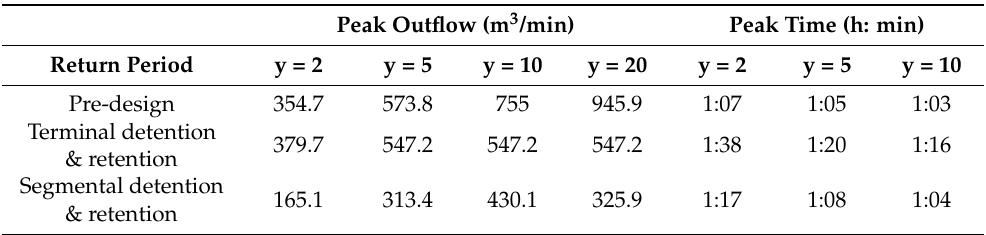
Table 6. Peak outflow at O2 and time to the peak outflow of the pre-design scheme, Scheme T and Scheme S in different return periods.